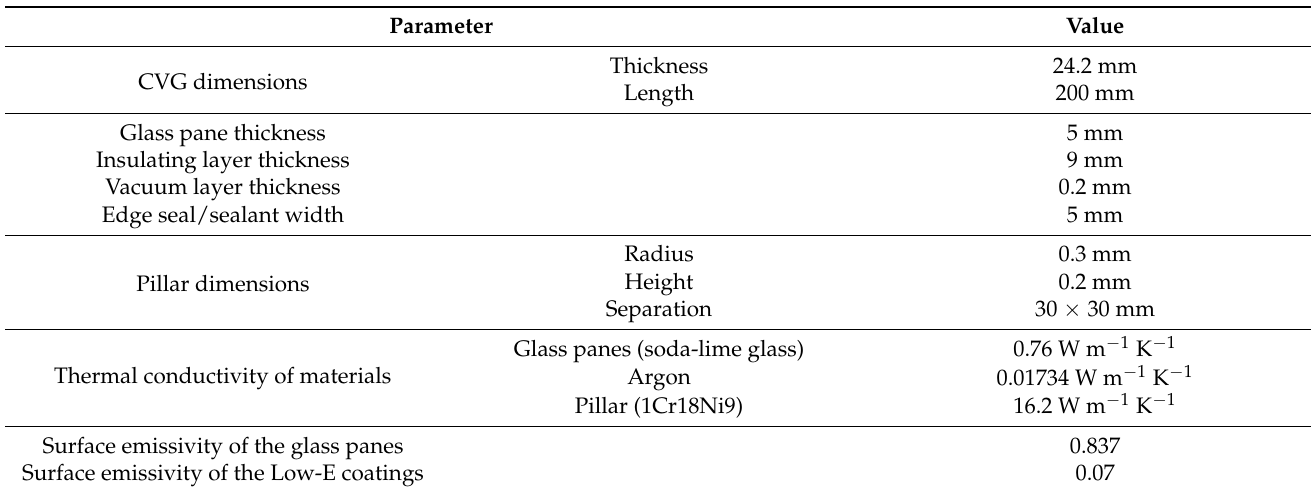
Table 1. Parameters of the CVG model.